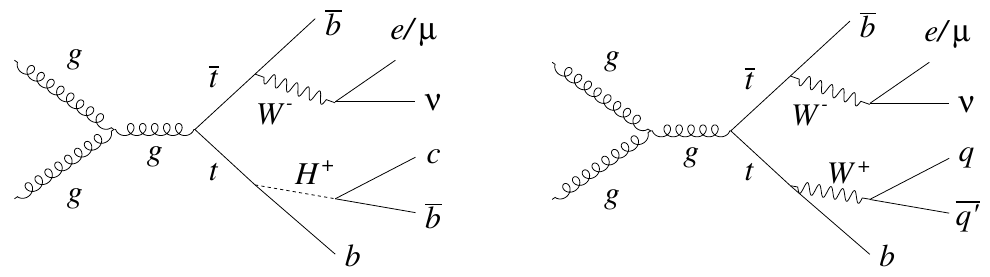
Figure 1 . Feynman diagrams of the H + production in top quark pair events (left) compared to the standard model production of tt in lepton+jets (cid:12)nal states